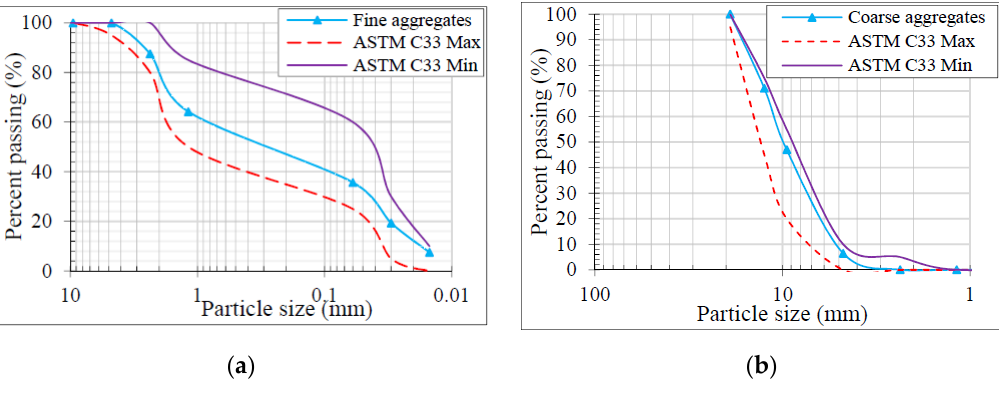
Figure 1. Granular analysis ( a ) fine aggregates ( b ) RCA. Table 2. Characteristics of fly ash. Table 1. Different properties of recycled aggregates.